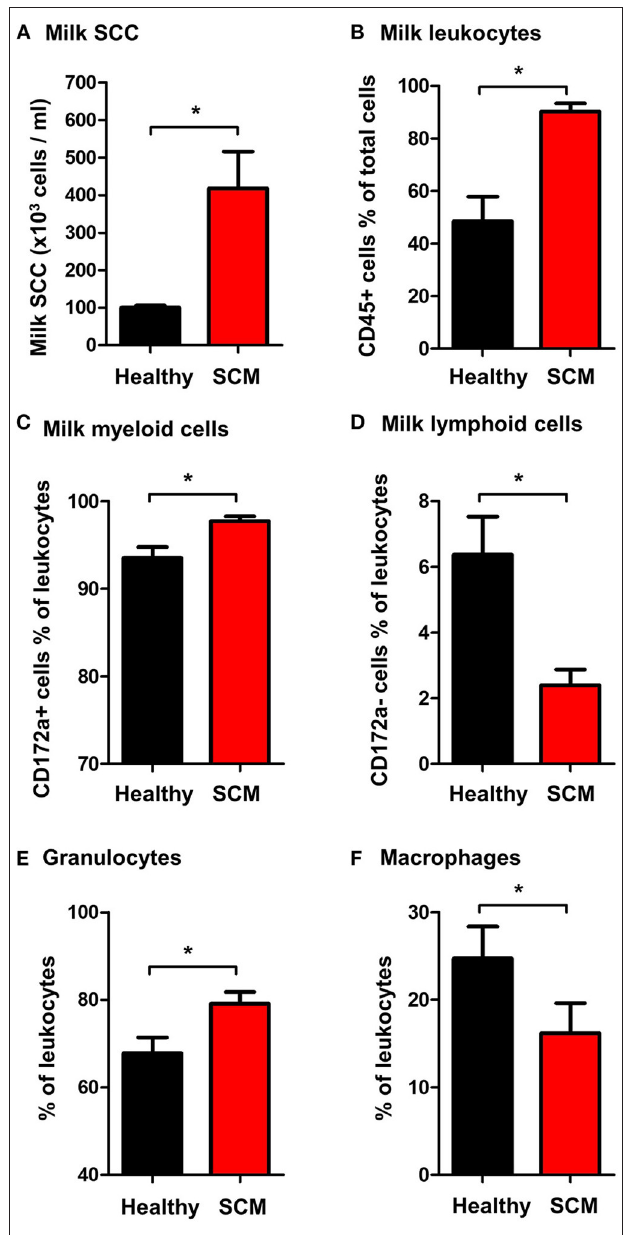
FIGURE 3 | (A) Somatic cell count (SCC) in milk samples from healthy camels and camels with subclinical mastitis (SCM). Milk SCC was counted using the direct microscopic method after fat globule removal by a spin-wash followed by staining with Turk solution and microscopic counting on a Neubauer cell counter. The percentage of (B) leukocytes (CD45 + cells % of total milk cells), (C) myeloid cells (CD172a + cells % of total leukocytes), (D) lymphoid cells (CD172a- cells % of total leukocytes), (E) granulocytes (CD172a + CD14low cells % of total leukocytes), and (F) macrophages (CD172a + CD14high cells % of total leukocytes) in milk samples from healthy and SCM camels as identified by flow cytometry after labeling milk cells with antibodies to CD45, CD172a, and CD14. *indicates significant differences between the means with p -values <